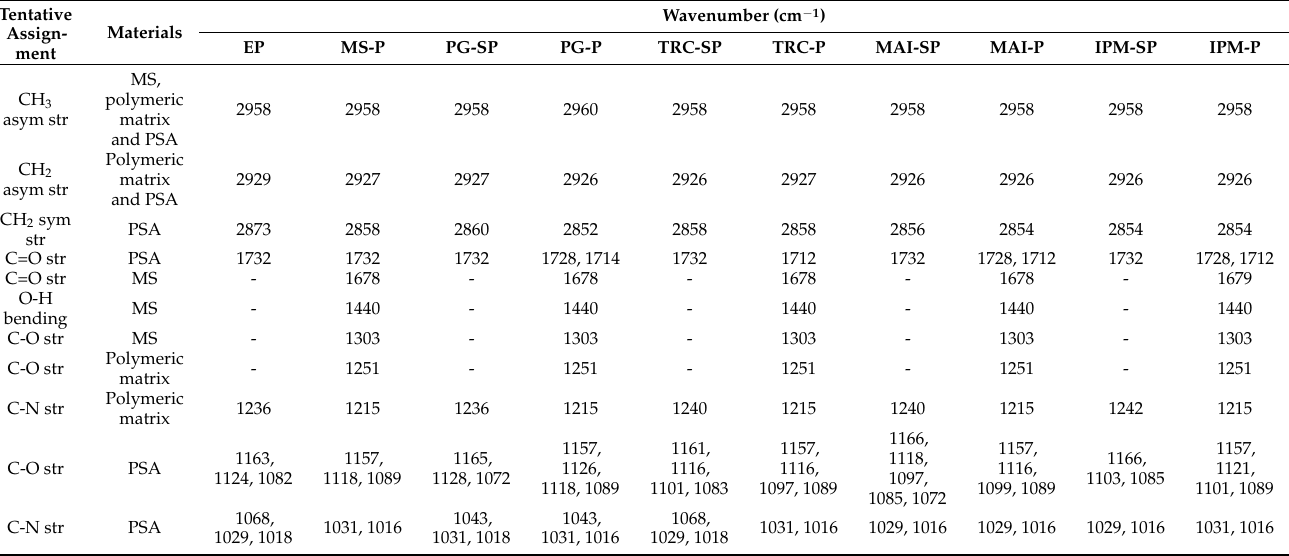
Table 4. FTIR spectral assignments of different patches prepared with and without solvent and/or